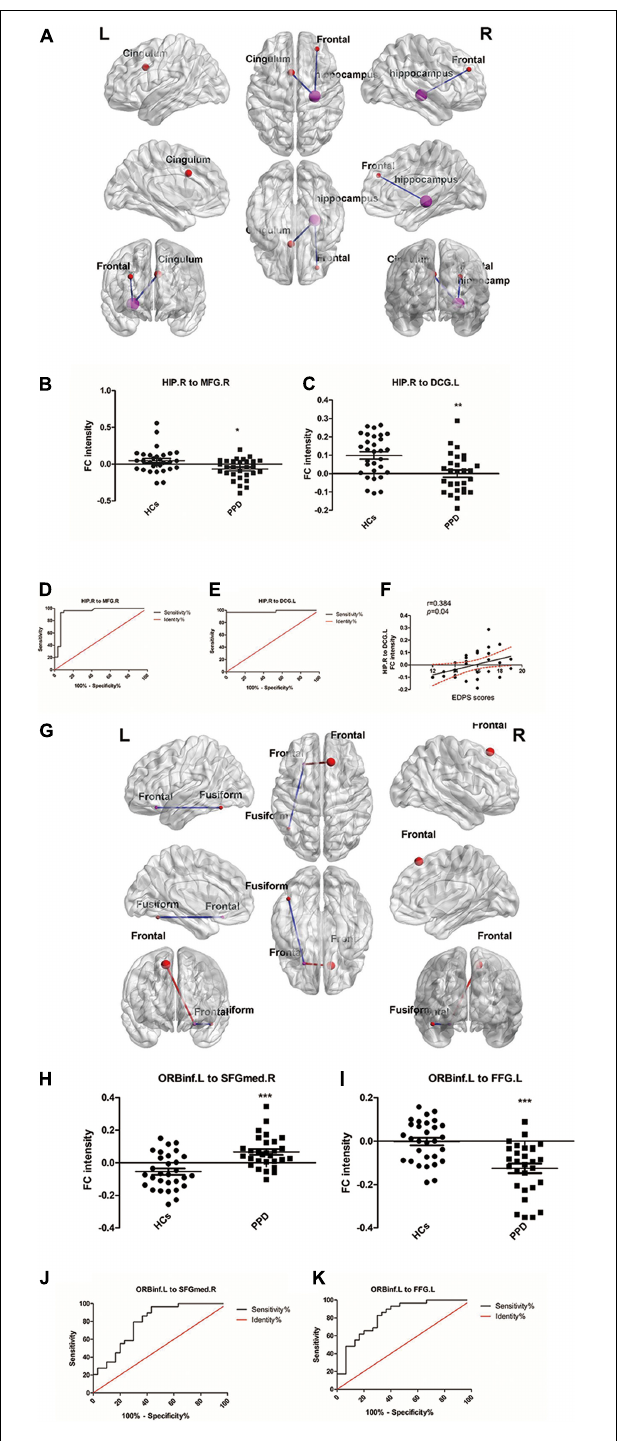
FIGURE 2 | (A) Brain regions showing aberrant functional connectivity (FC) with HIP.R (seed region) in the PPD group compared with the HCs. Cool color represents significantly decreased FC. (B,C) Mean values of the abnormal functional connectivity in these groups. (D,E) The ROC curve evaluates the diagnostic value of the FC value of different brain regions to distinguish patients with PPD from healthy mothers, in which HIP.R was as